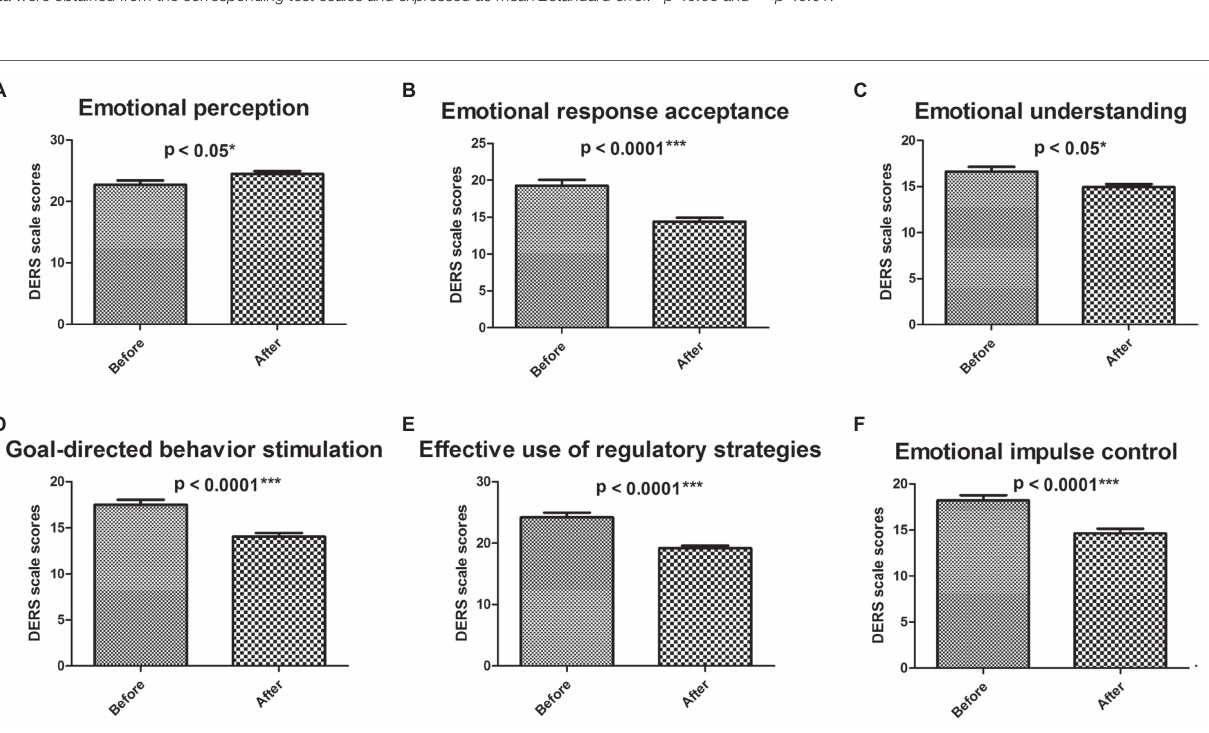
FIGURE 5 | Analysis of DERS scores in six dimensions before and after intervention for experimental group. The dynamic DERS scores of six dimensions before and after GMIT intervention in control group and experimental group. The scores of emotion perception (A) , emotional response acceptance (B) , emotion understanding (C) , goal-directed behavior stimulation (D) , effective use of regulatory strategies (E) , and emotional impulse control (F) . * p < 0.05 and *** p < 0.001.